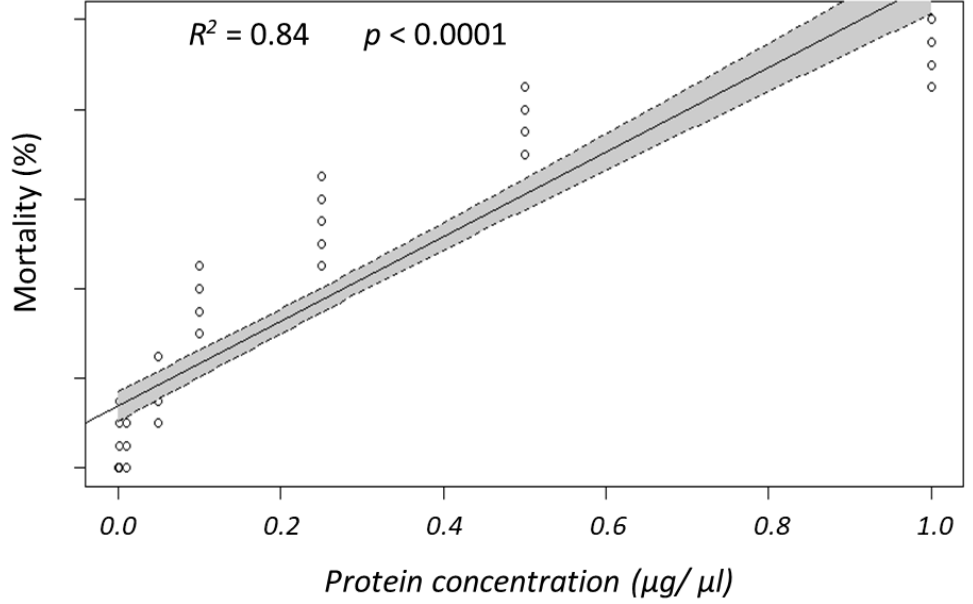
Figure 3. Relationship between Meloidogyne incognita mortality and concentration of the protein extract from the Brevibacillus laterosporus culture supernatant at the sporulation phase. Shaded areas in the linear regression plot represent 95% confidence intervals.